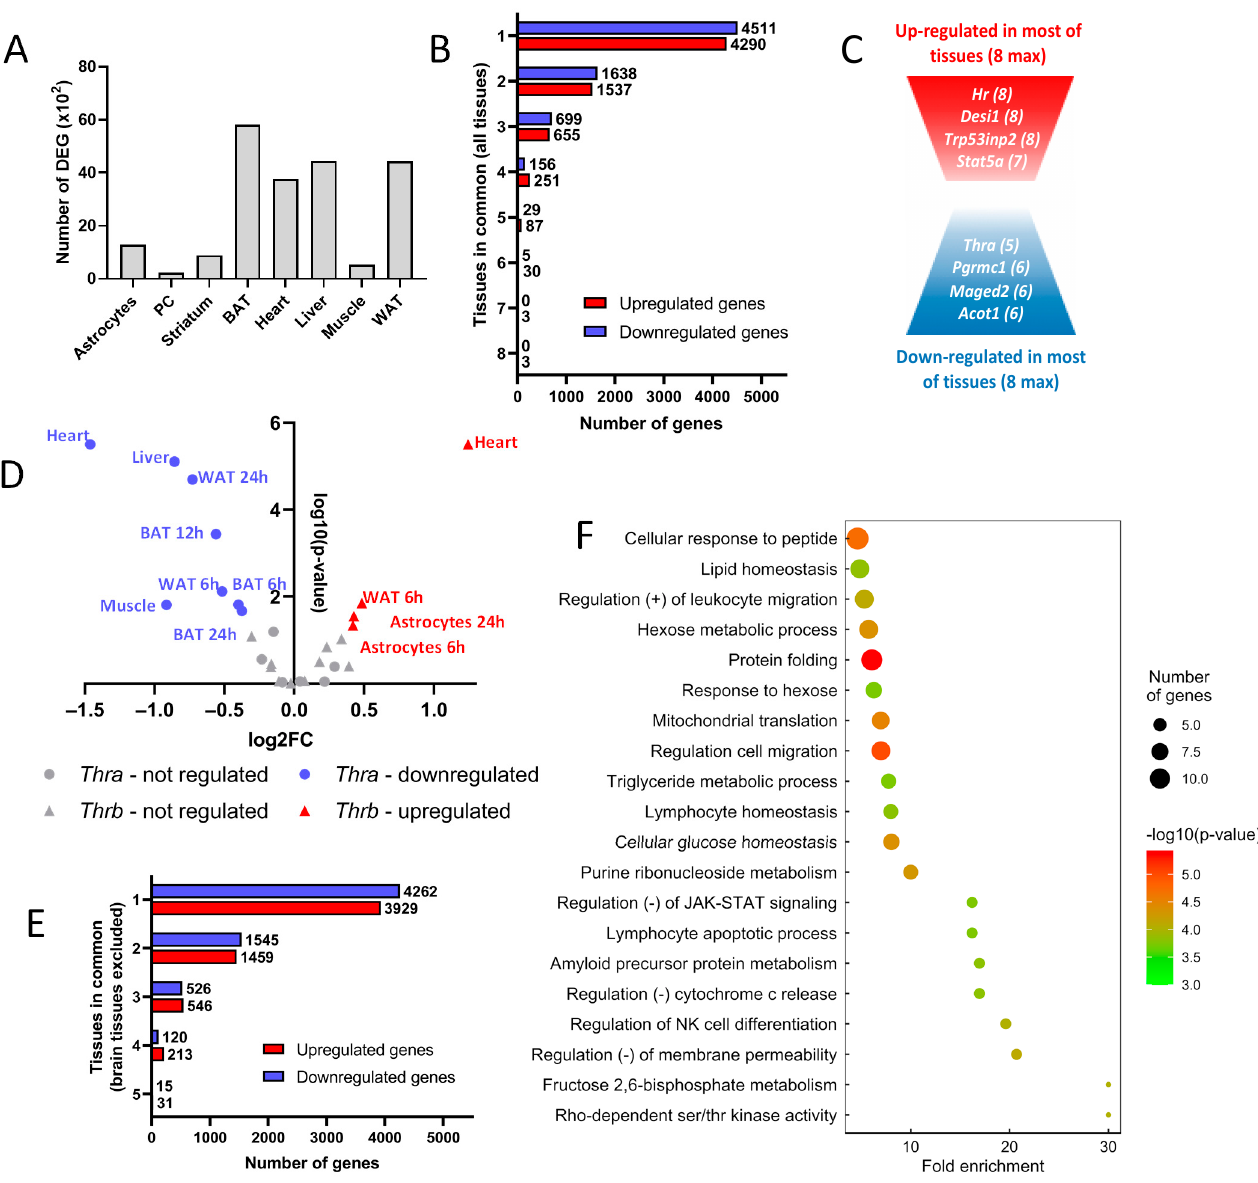
Figure 1. Thyroid hormone regulates the expression of tissue-specific genes. ( A ) Number of differen- tially expressed genes (DEG, × 10 2 ) in available tissues. ( B ) Number of genes up- or downregulated shared between tissues. Genes were classified into eight categories, depending on the number of tissues within which they were regulated. ( C ) Schematic representation of the up- and downregulated genes shared among tissues. ( D ) Regulation of Thra (circle) and Thrb (triangle) by thyroid hormone. Log 2 fold-change and statistical significance were plotted for each time point of each tissue. When the regulation was significant (that is, when the − log 10 p -value > 1.3, which means the p -value < 0.05), tissues within which Thra or Thrb were up- or downregulated were colored red and blue, respectively. The name of the tissue and the time point of the kinetics were attributed to each point. ( E ) Number of genes up- or downregulated among tissues, excluding brain tissues. Genes were classified into five categories, depending on the number of tissues within which they were regu- lated. ( F ) Gene ontology dot plot of the genes upregulated in at least four of the five non-brain tis- sues. Some of the terms were shortened to increase the readability without affecting the meaning.